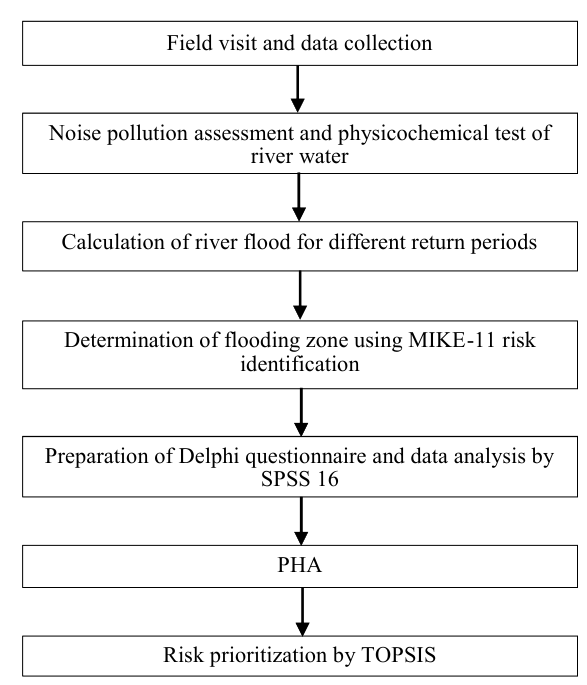
Fig. 2: Procedure of risk assessment of Gavi Dam